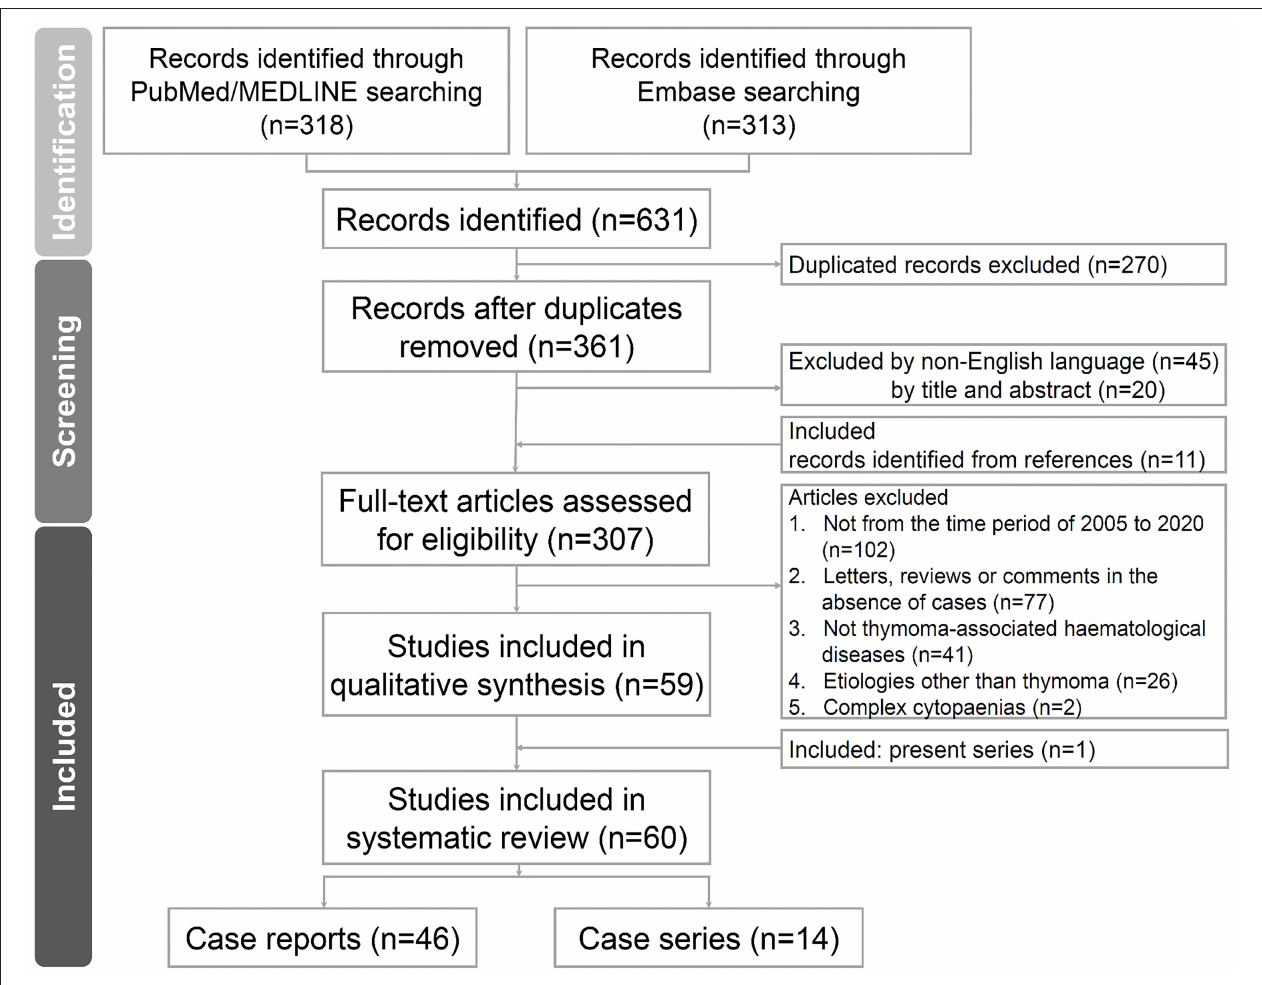
FIGURE 1 | Flow diagram of the study. The flow diagram of the enrolled studies following PRISMA algorithm. PRISMA, preferred reporting items for systematic reviews and